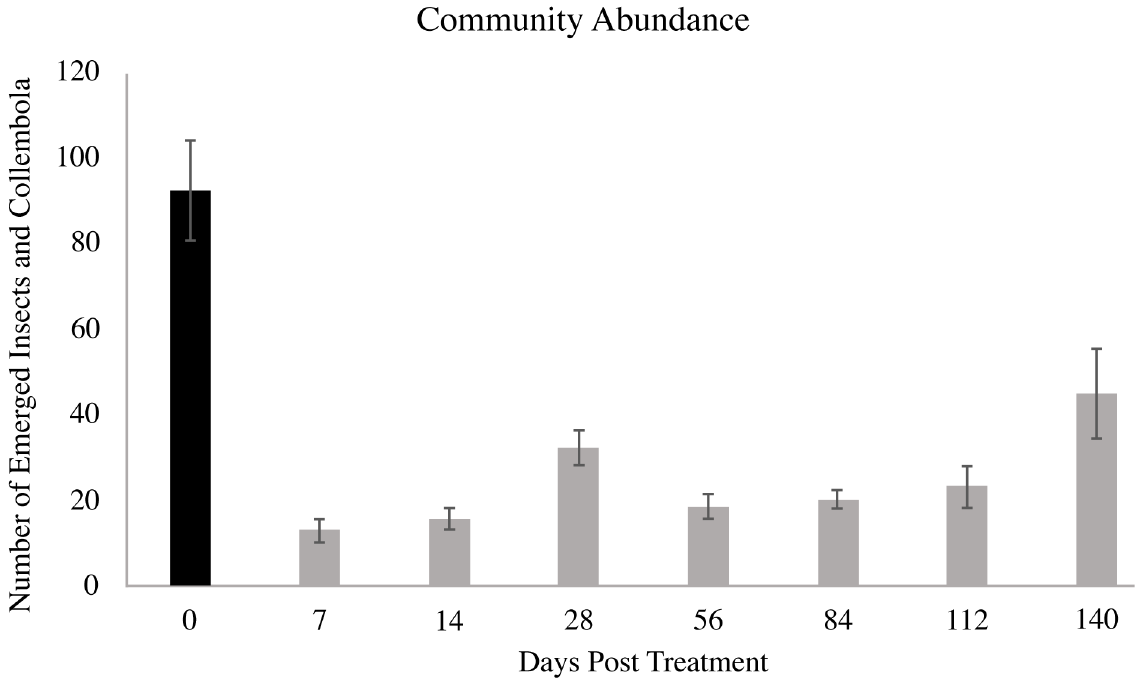
Fig 1. Total insect and Collembola emergence. The total number of insects and Collembola that emerged from dung (500 g) deposited by cattle before (day 0) and 7, 14, 28, 56, 84, 112, and 140 d after subcutaneous injection of LongRange eprinomectin (1 mg eprinomectin kg -1 body weight). Error bars denote the respective standard error of the mean. Statistical analysis compared the control (day 0) to each post- injection sampling day. Reported means and standard errors are from un-ranked data, while significance was based on analyses of rank- transformed data. Grey bars indicate values that are different ( P < 0.05) than the control (day 0).